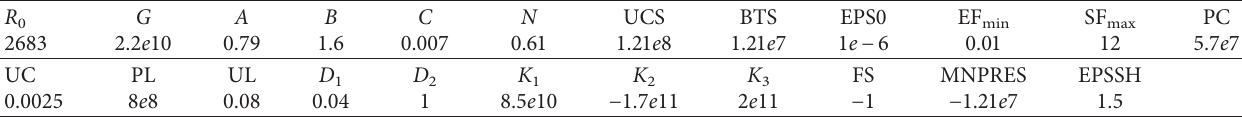
Table 1: Detailed parameters of granite.